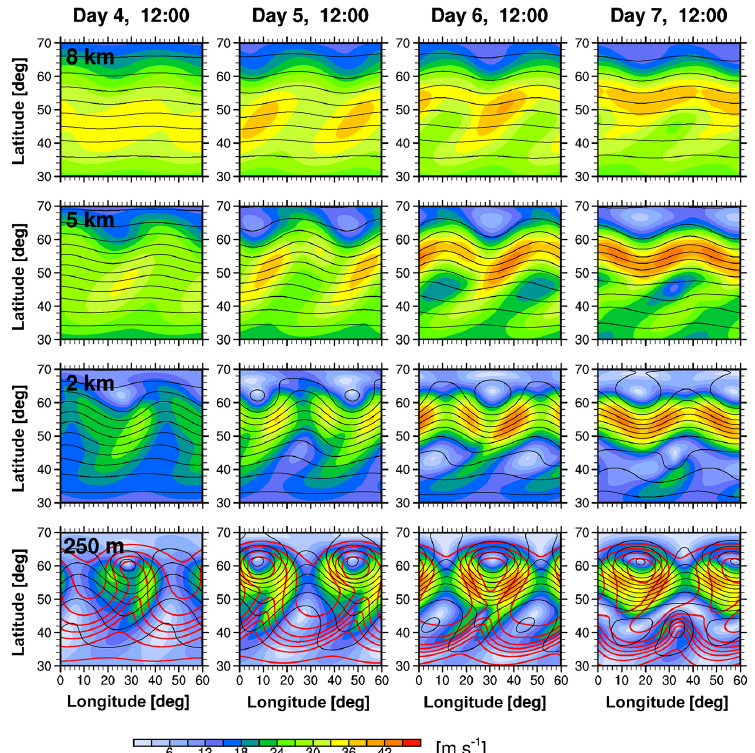
Figure 1. Background fields of the pressure (black contour) and horizontal wind speed (shading) at z = 0 . 25, 2, 5, and 8km (from bottom to top) on days 4, 5, 6, and 7 at 12:00UTC (from left to right). The background potential temperature is also plotted at z = 0 . 25km (red contour). The contour intervals for the pressure and potential temperature are 8hPa and 8K,